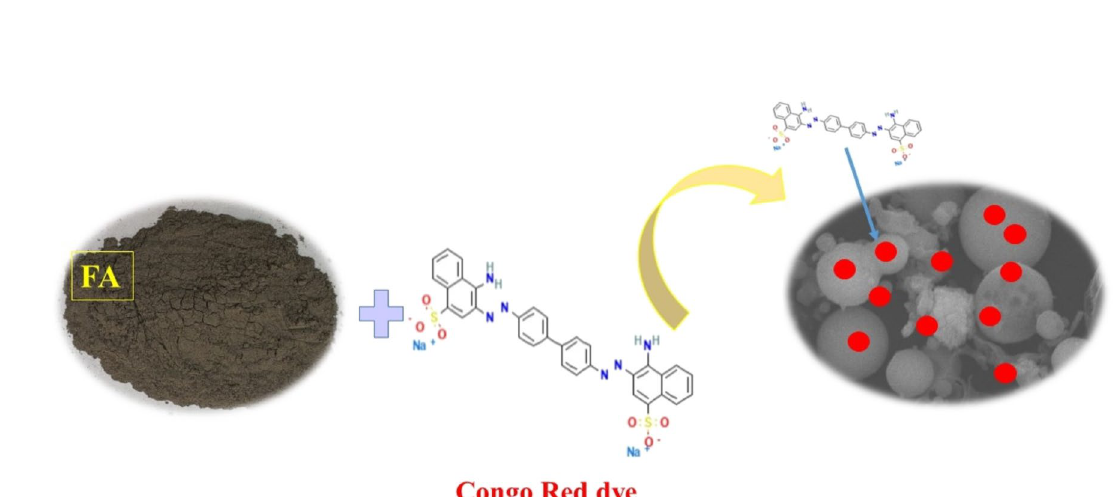
Figure 23. Adsorption mechanism of CR dye adsorption by